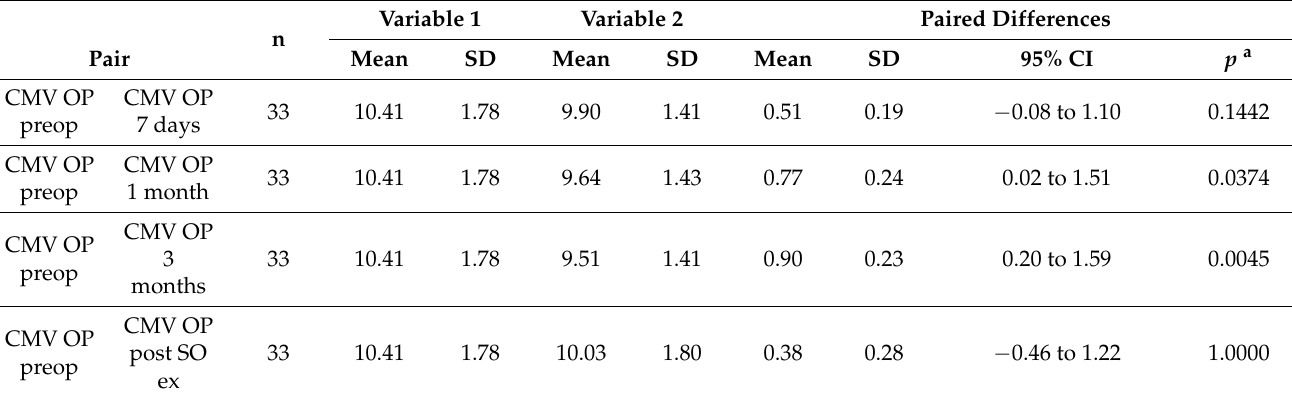
Table 4. Central macular volume cube CMV (mm3) in PPV SO operated